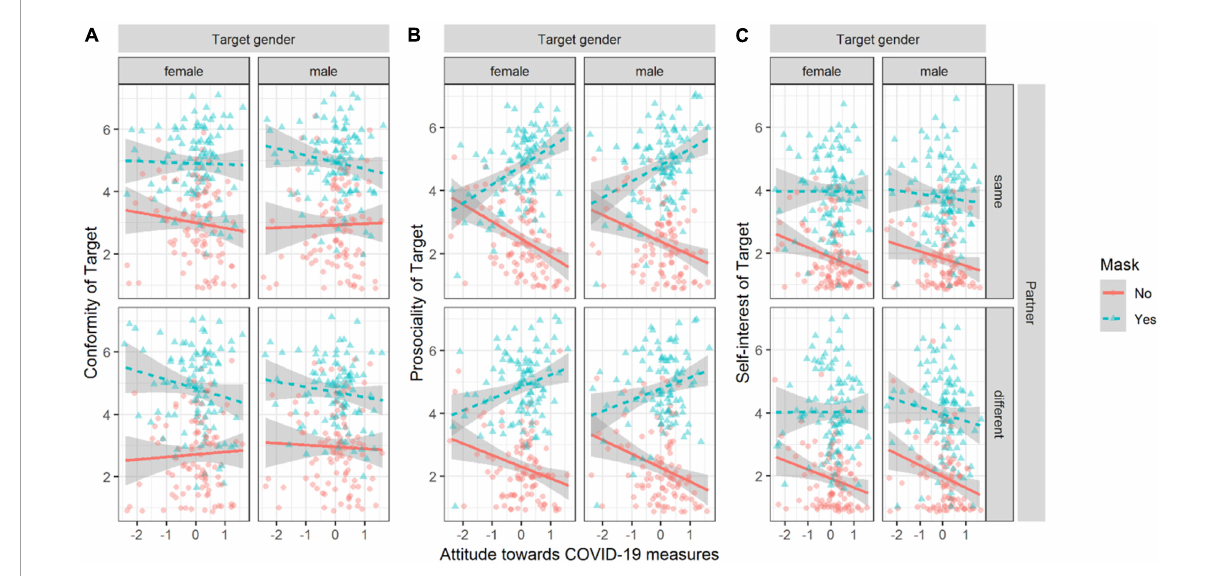
FIGURE4 Perceived judgment of the target person depending on mask, partner, and gender of target person. Plot (A) for perceived conformity, plot (B) for perceived prosociality, and Plot (C) for self-interest. Lines depict linear regression of Y on X; the shaded area indicates the 95% CI of the estimate. Points are jittered to avoid